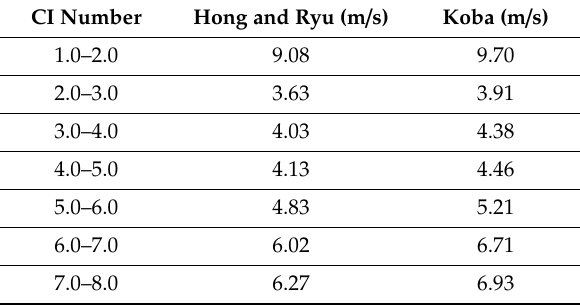
Table 4. RMSE values for each CI number according to the Hong and Ryu and Koba scales calculated using ADT TC intensity data (2015 – 2018).